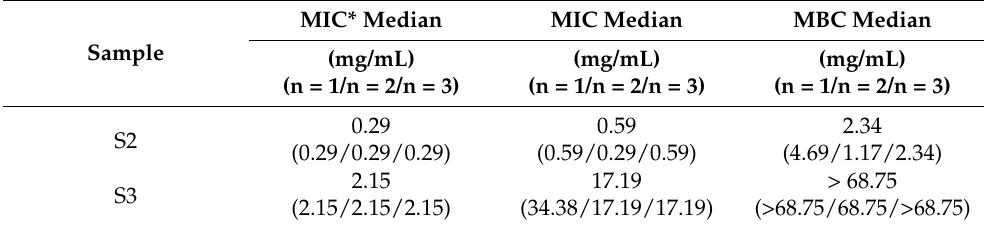
Table 5. Antibacterial activity of sardine extracts against C. acnes